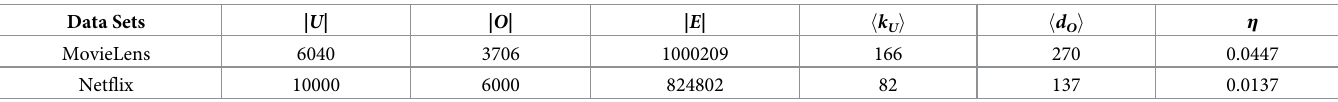
Table 2. Basic statistical properties of the empirical data sets used in this paper. | U |, | O | and | E | denote the cardinality of users, objects and ratings, respectively. h k and h d O i are the average degree of users and objects, respectively. η records the network